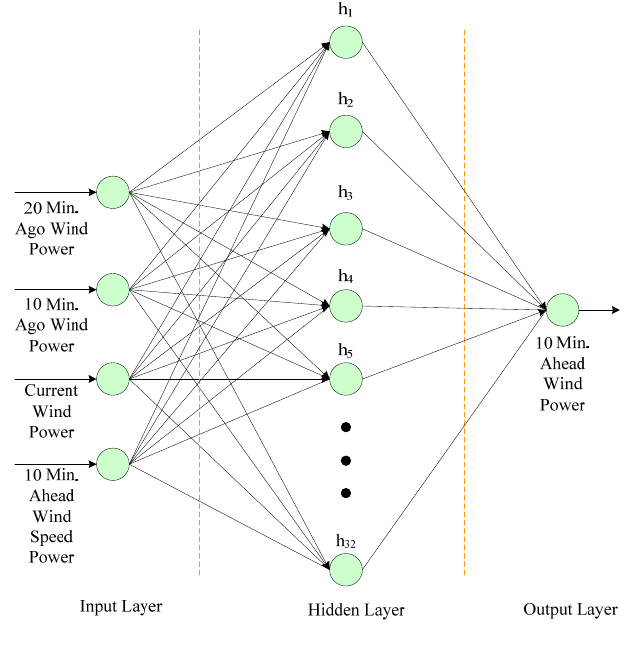
Figure 2. Architecture of the back propagation neural network based and RBF neural network based wind power forecasting